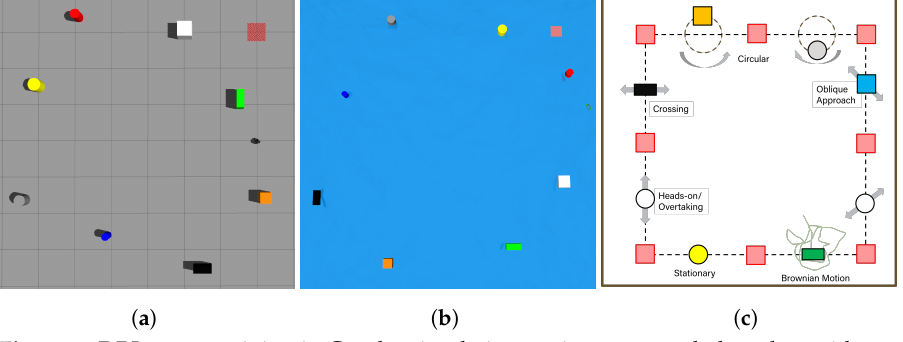
Figure 8. DRL agent training in Gazebo simulation environment and obstacle avoidance mission setup for the DRL agent training. ( a ) UGV training environment. ( b ) USV training environment. ( c ) Obstacle motion